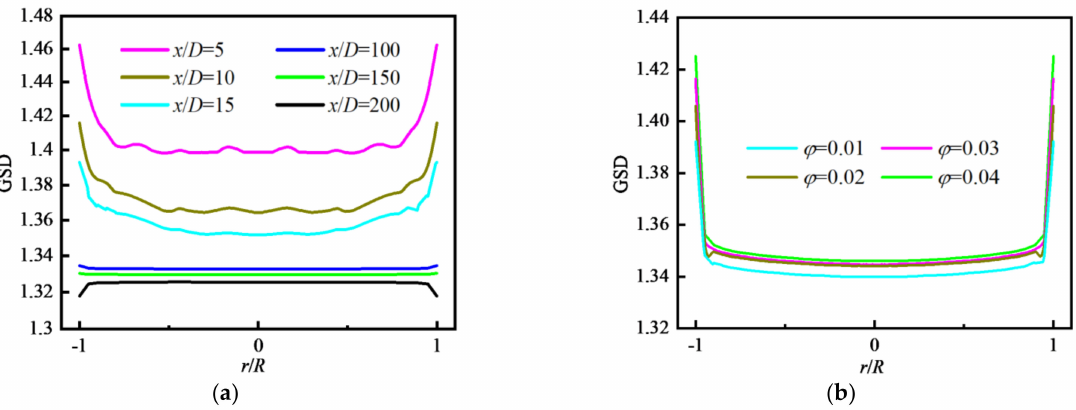
Figure 12. Distribution of GSD along the radial direction with different ϕ : ( a ) ϕ = 0.04; ( b ) x/D =